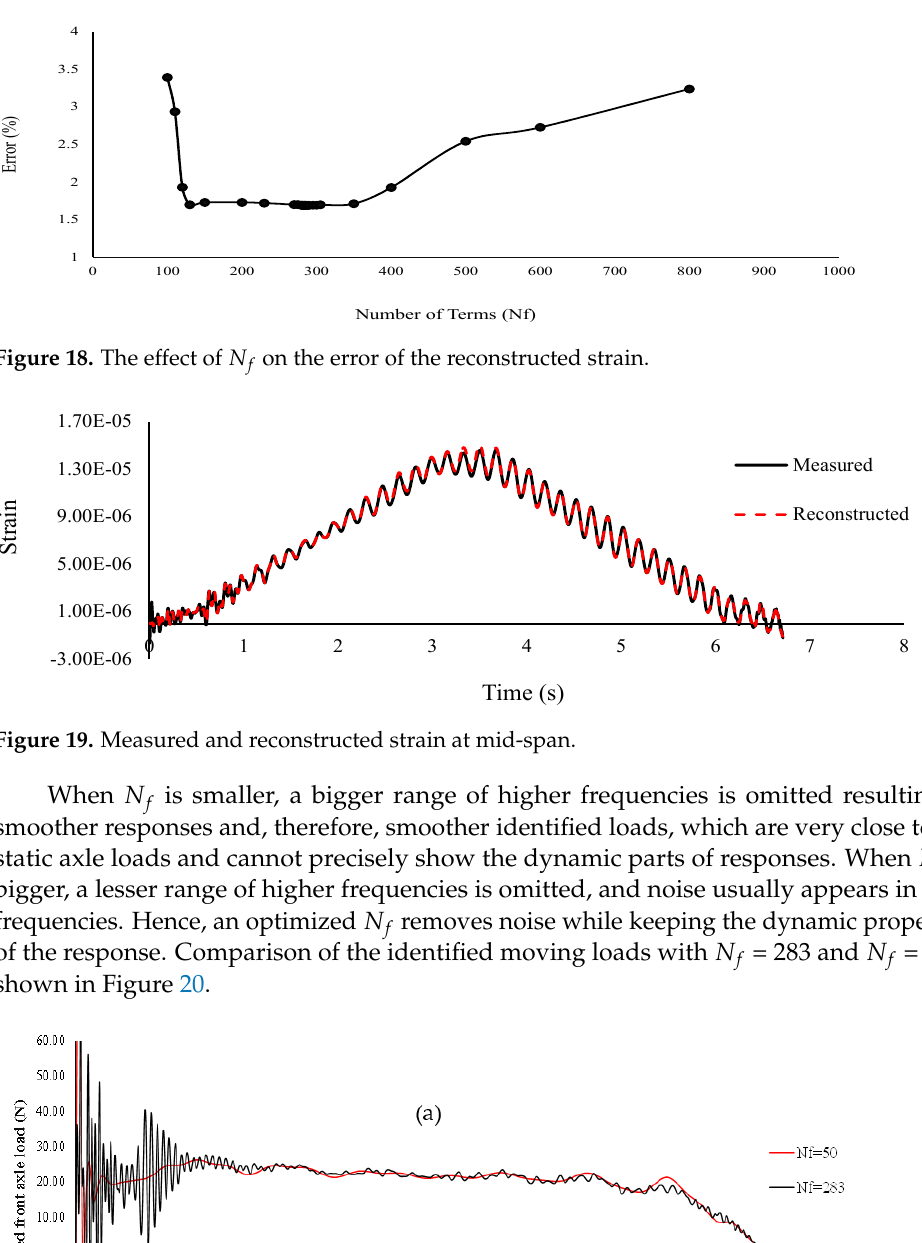
Figure 20. Comparison of the effects of a small N f and the optimized value on the identified axle loads. ( a ) Identified front axle load, ( b ) identified rear axle load. 6.6. The Effect of Different Measurement Arrangements To investigate the effect of sensor arrangements on identifying moving loads, seven- teen different cases were studied, as tabulated in Table 10. The vehicle was pulled over the beam at an average speed of 0.47 m/s, and the sampling frequency was set at 200 Hz. Strain measurements were smoothed by the Chebyshev polynomial with 𝑁 (cid:3033) = 283, and converted into nodal displacements. The Tikhonov regularization method was used to identify moving loads and the optimal regularization parameter was obtained by the L-curve method.